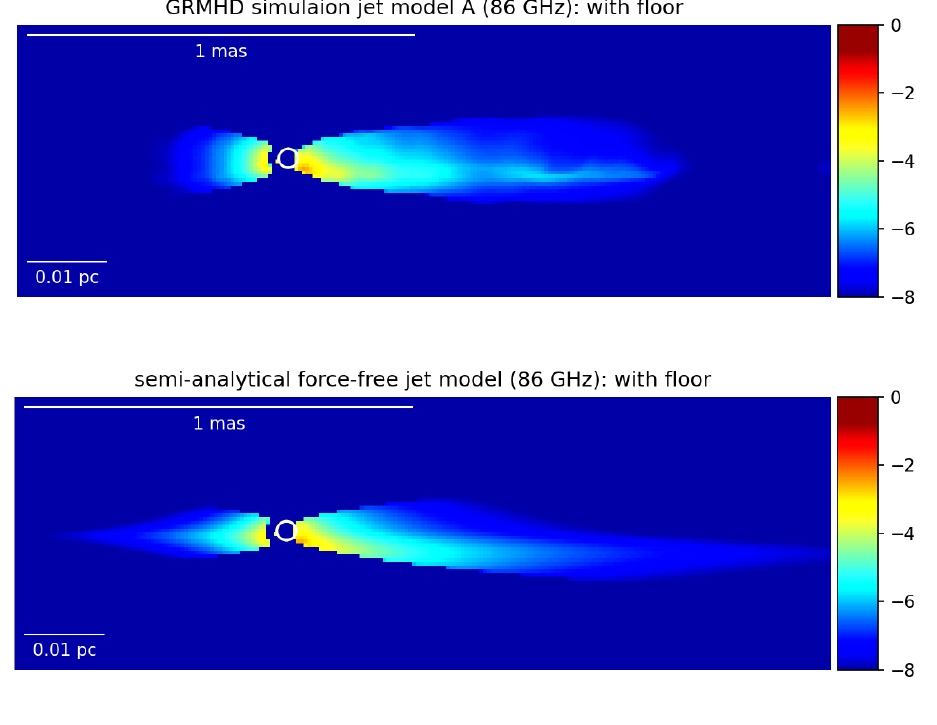
Figure 6. Same as Figure 5, but for 86